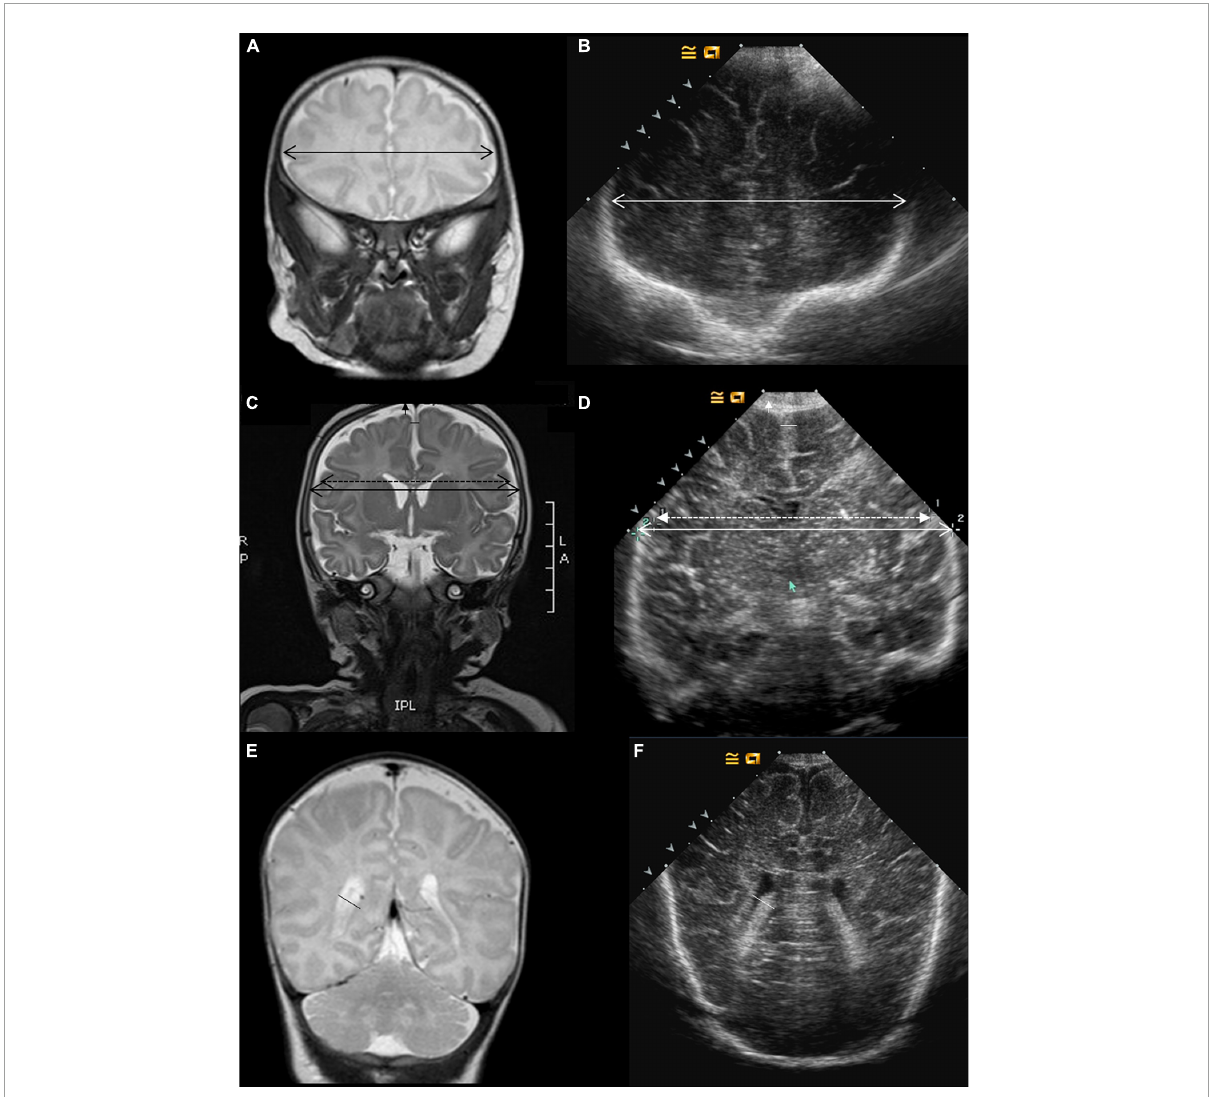
FIGURE1 Imaging metrics protocol. MRI and ultrasound coronal views. The following metrics were compared on coronal, T2-weighted MRI sequences (A,C,E) and ultrasound scans (B,D,F) : bi-frontal diameter (A,B) , and lateral ventricle diameter (E,F) . On panels (C , D) , the bone parietal diameter is shown in plain double head arrow and the brain parietal diameter in the discontinued double head arrow. Measurements of extra-cerebral spaces include the subarachnoid (vertical arrowhead) and the inter-hemispheric spaces (horizontal